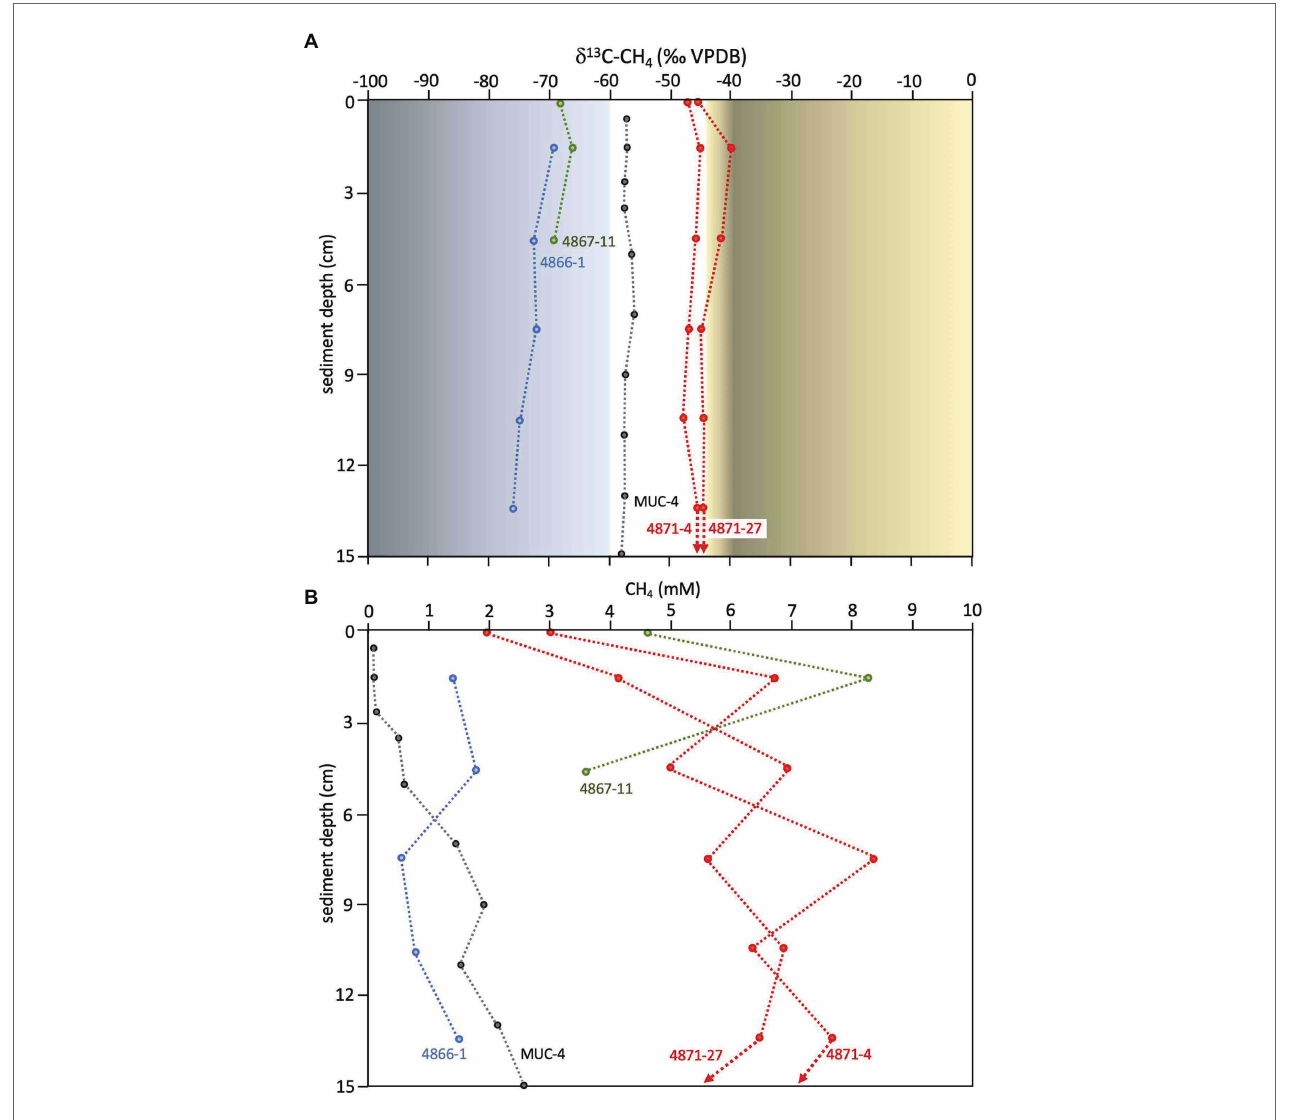
FIGURE 6 | Methane isotopic values and concentrations. (A) Methane δ 13 CH 4 values (VPDB) for Octopus Mound cores 4866-1 (active site, in blue) and 4867-11 (hydrate site, in green), and the nearby sediment push core MUC-4 (black), previously collected and measured independently at Central Seep (Geilert et al., 2018). Methane δ 13 CH 4 values (VPDB) for hydrothermal cores from the Northern Towers area (4871-4 and 4871-27) are plotted in red. Orange shading indicates the range of δ 13 CH 4 values for thermogenic methane in hydrothermal sediments in the southern Guaymas axial valley (McKay et al., 2016). Blue shading indicates the range of δ 13 CH 4 values for microbially produced methane in cold sediments of the Sonora Margin (Vigneron et al., 2015, Teske et al., 2019), delimited at 60‰ based on Schoell (1982) and Simoneit et al. (1986). (B) Methane concentrations for the same samples. Data points for supernatant samples are plotted at 0 cm depth. δ 13 CH 4 values and their standard deviations, and methane concentrations are tabulated in Supplementary Table S4